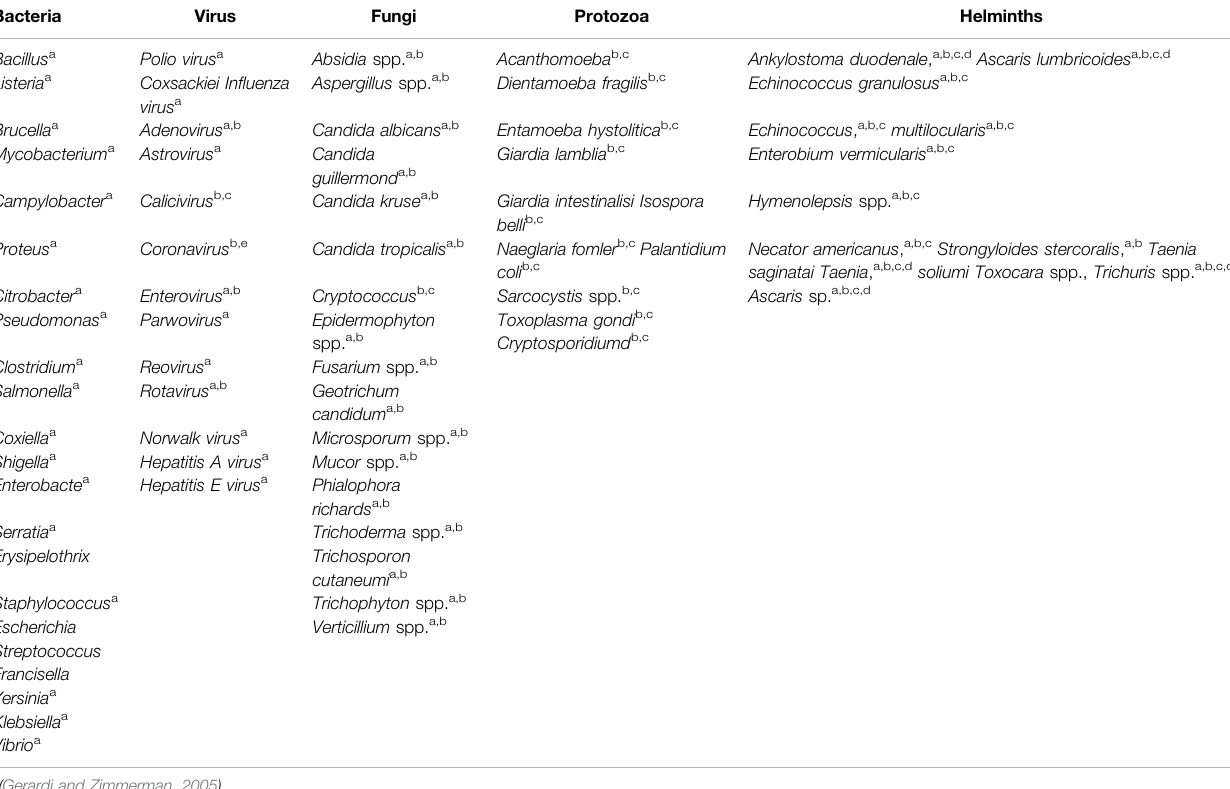
TABLE 6 | Different groups of isolated microorganisms in